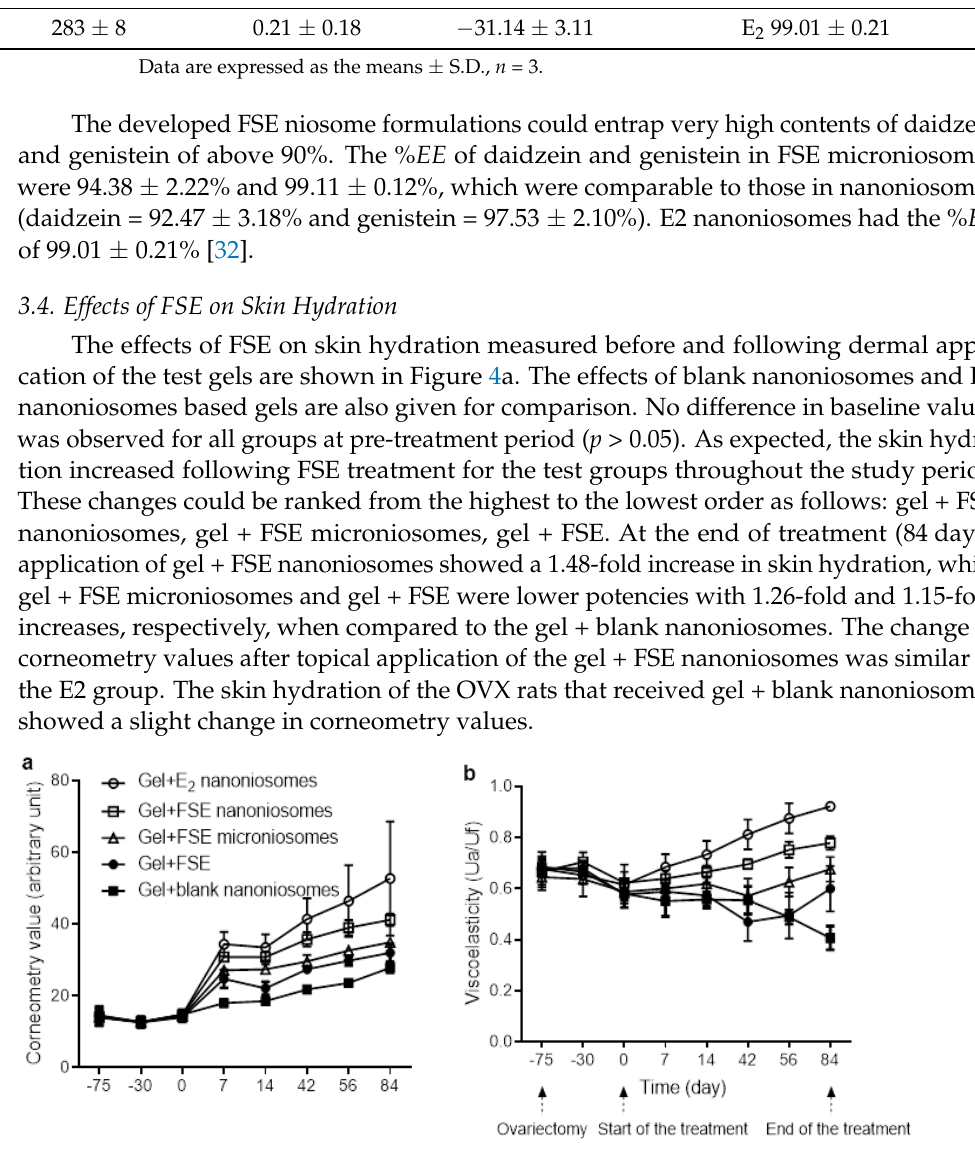
Figure 4. Effects of dermal application of various FSE formulations on ( a ) skin hydration and ( b ) viscoelasticity in the OVX rats. Values are expressed as mean ± SD ( n = 4 – 5 ).